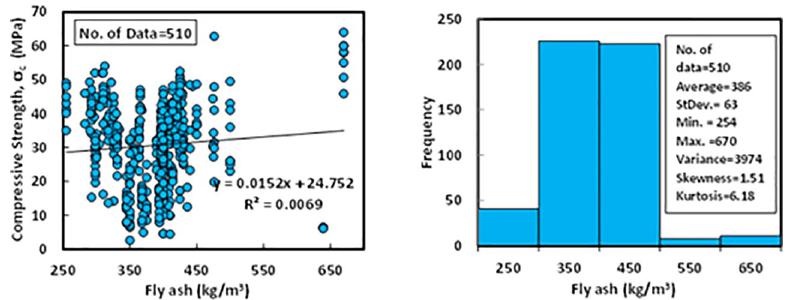
Fig 4. Variation between compressive strength and fly ash content with a histogram of fly ash-based geopolymer concrete mixtures.